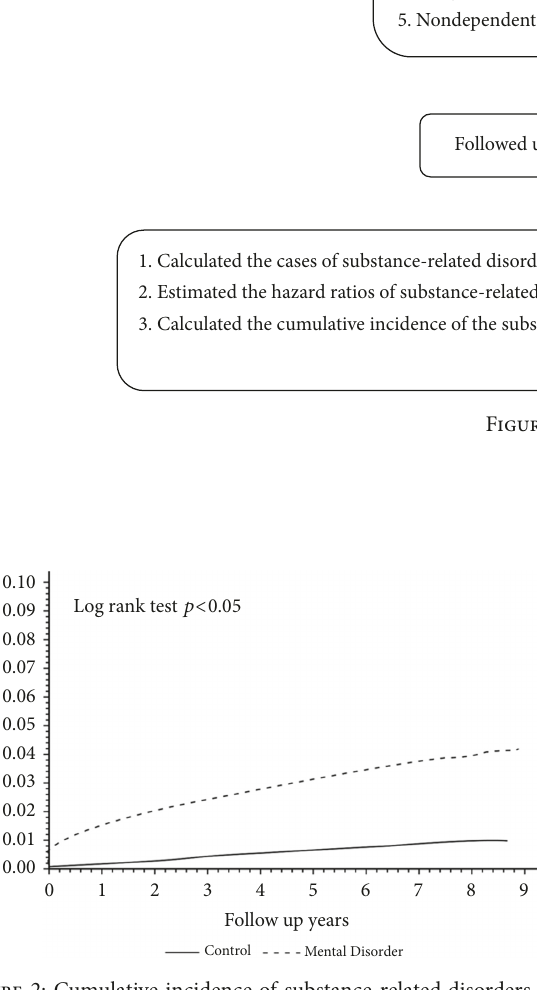
Figure 2: Cumulative incidence of substance-related disorders in patients with mental disorders compared to those